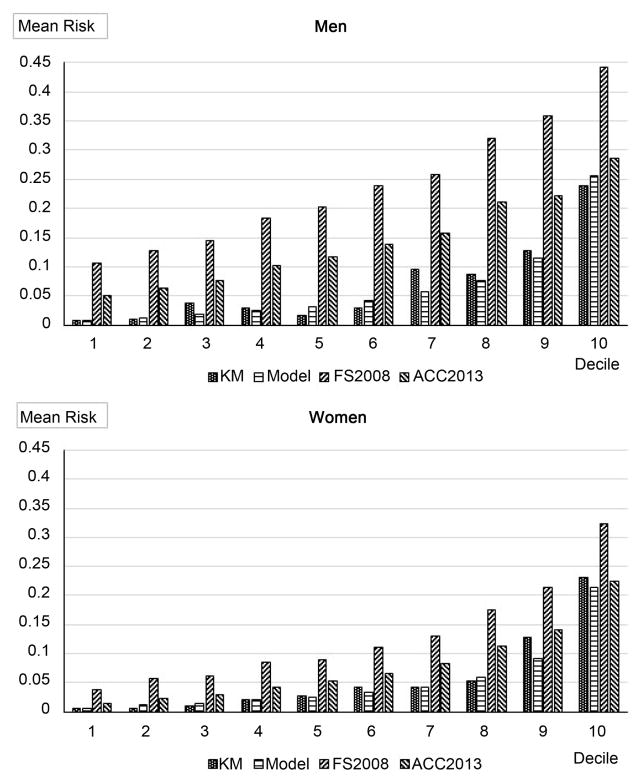
Calibration by deciles of model-based predicted probabilities of stroke event in 10 years. “KM” denotes observed risk (by using Kaplan-Meier method). “Model” denotes the models in Table 3 based predicted, “FS2008” the Framingham 2008 models based predicted, and “ACC2013” the ACC/AHA 2013 models (for White) based predicted de-cile specific risk means in deciles.